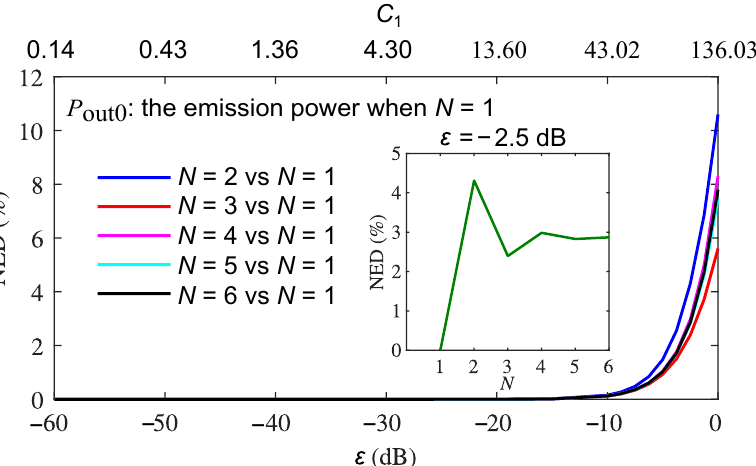
Figure 5. NED between the emission power with varying N and the emission power reference when N = 1 as a function of reinjection coupling factor ε and the feedback parameter C 1